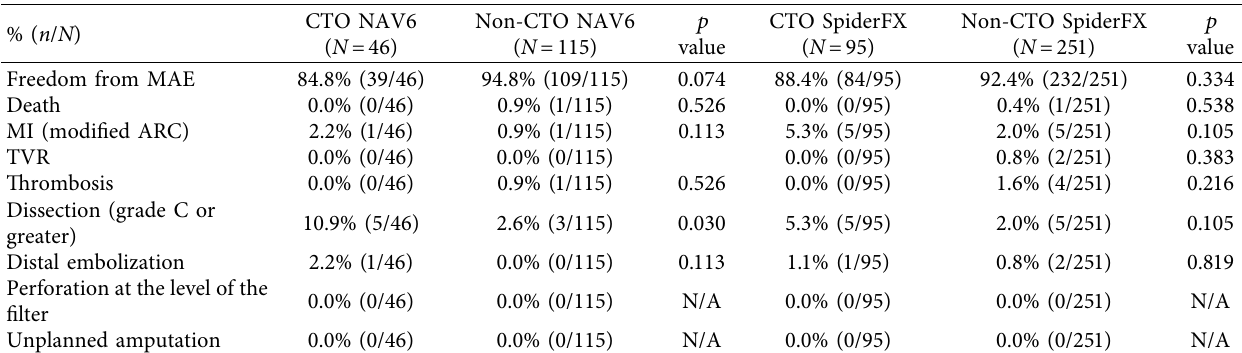
Table 6: Subset analysis of event rates by chronic total occlusions in the Emboshield NAV6 group.